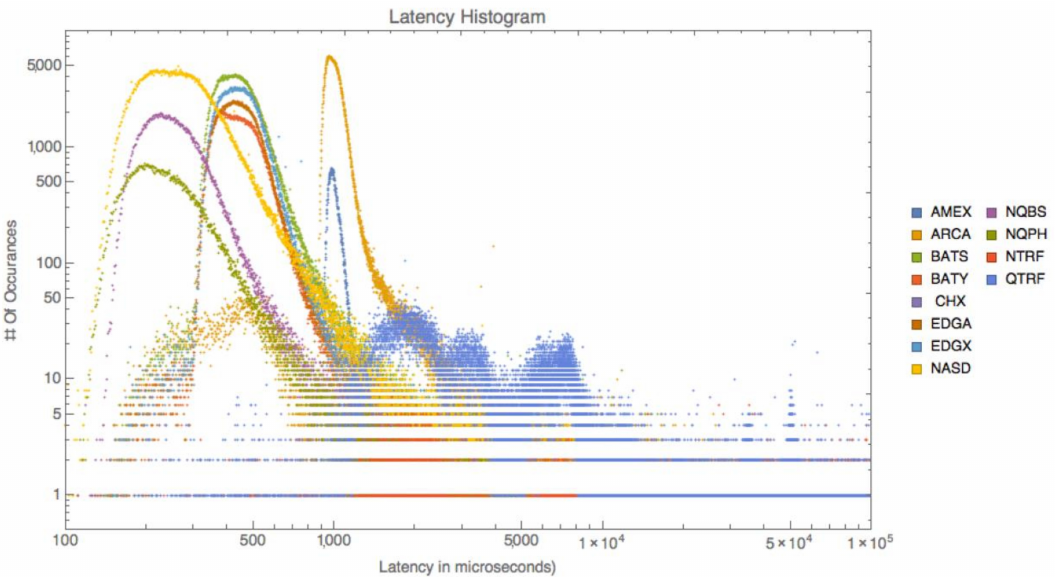
Figure 13. Latency histogram for Apple stock traded on 11 August 2015 by exchange for AAPL (truncated at 10 5